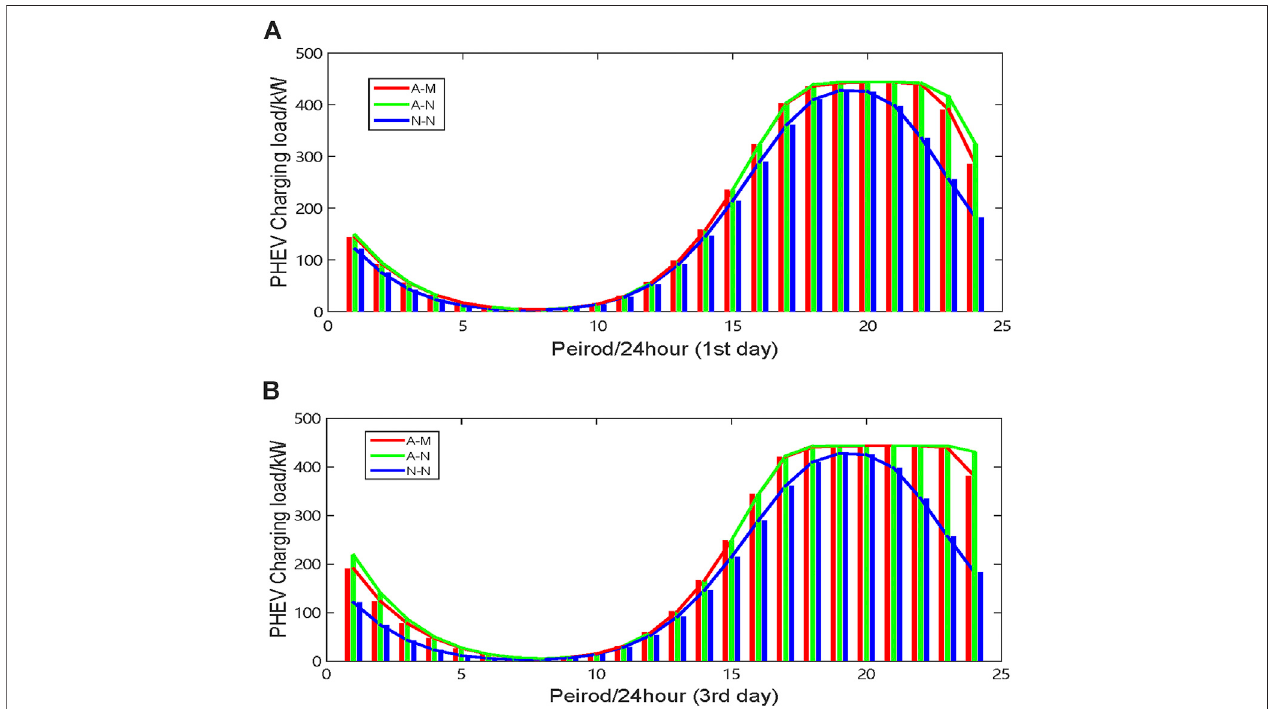
FIGURE 7 | Load variation of charging station A. (A) Charging load in the fi rst 24 h (1 st day). (B) Charging load in the third 24 h (3 rd day) (A – M, GSNs are attacked and PHEVs move to charge; A – N, GSNs are attacked and PHEVs do not move to charge; N – N, GSNs work normally and PHEVs do not move to charge).